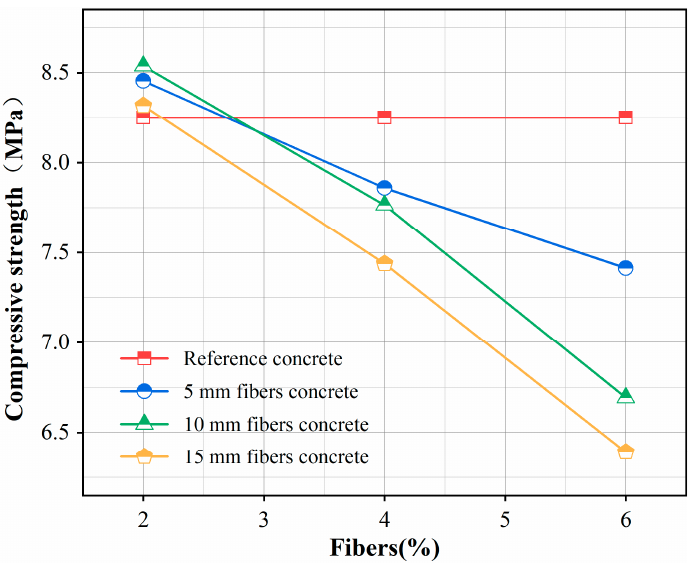
Figure 11. Compressive strength of the fiber insulation mortar measured at day 28.